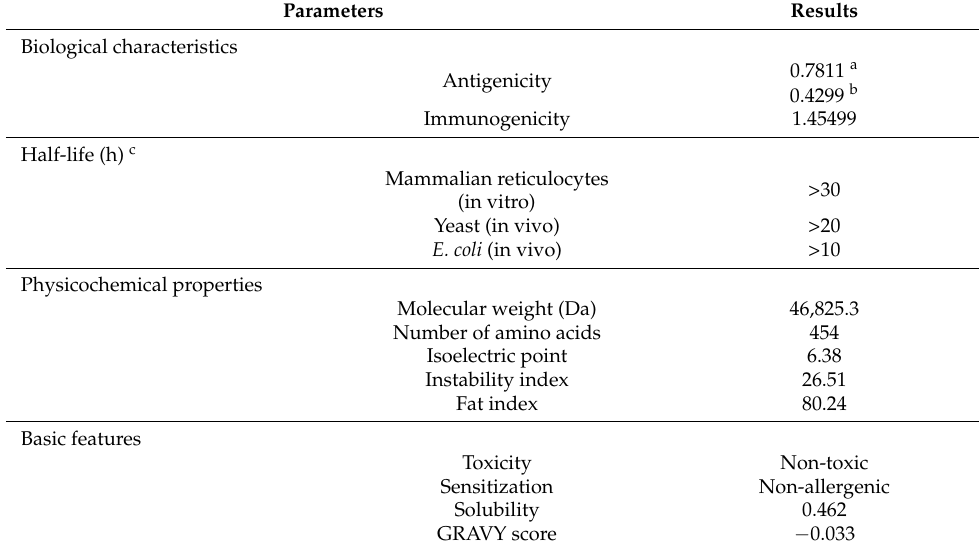
Table 2. Prediction of S7D5L4